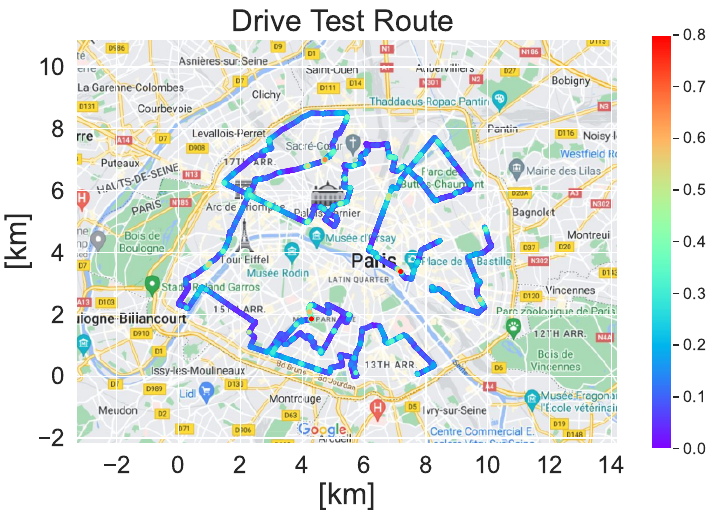
Figure 3. Drive test route in